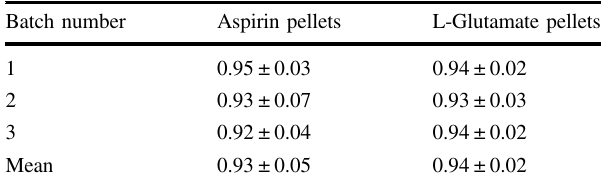
Table 9 The sphericity of aspirin and L-glutamate drug-loaded pellets Table 10 Content uniformity of aspirin in compound enteric-coated